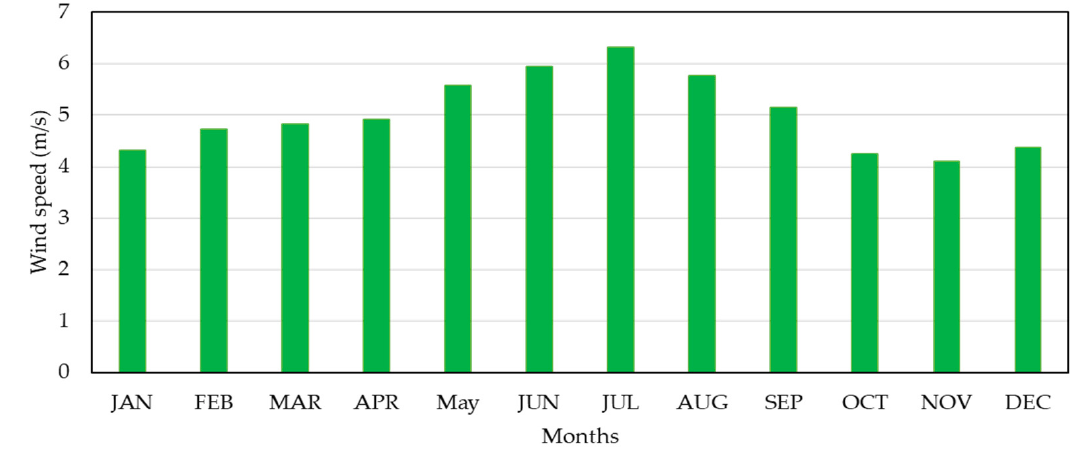
Figure 8. Monthly average wind speed profile at the Al-Dhafrat area.